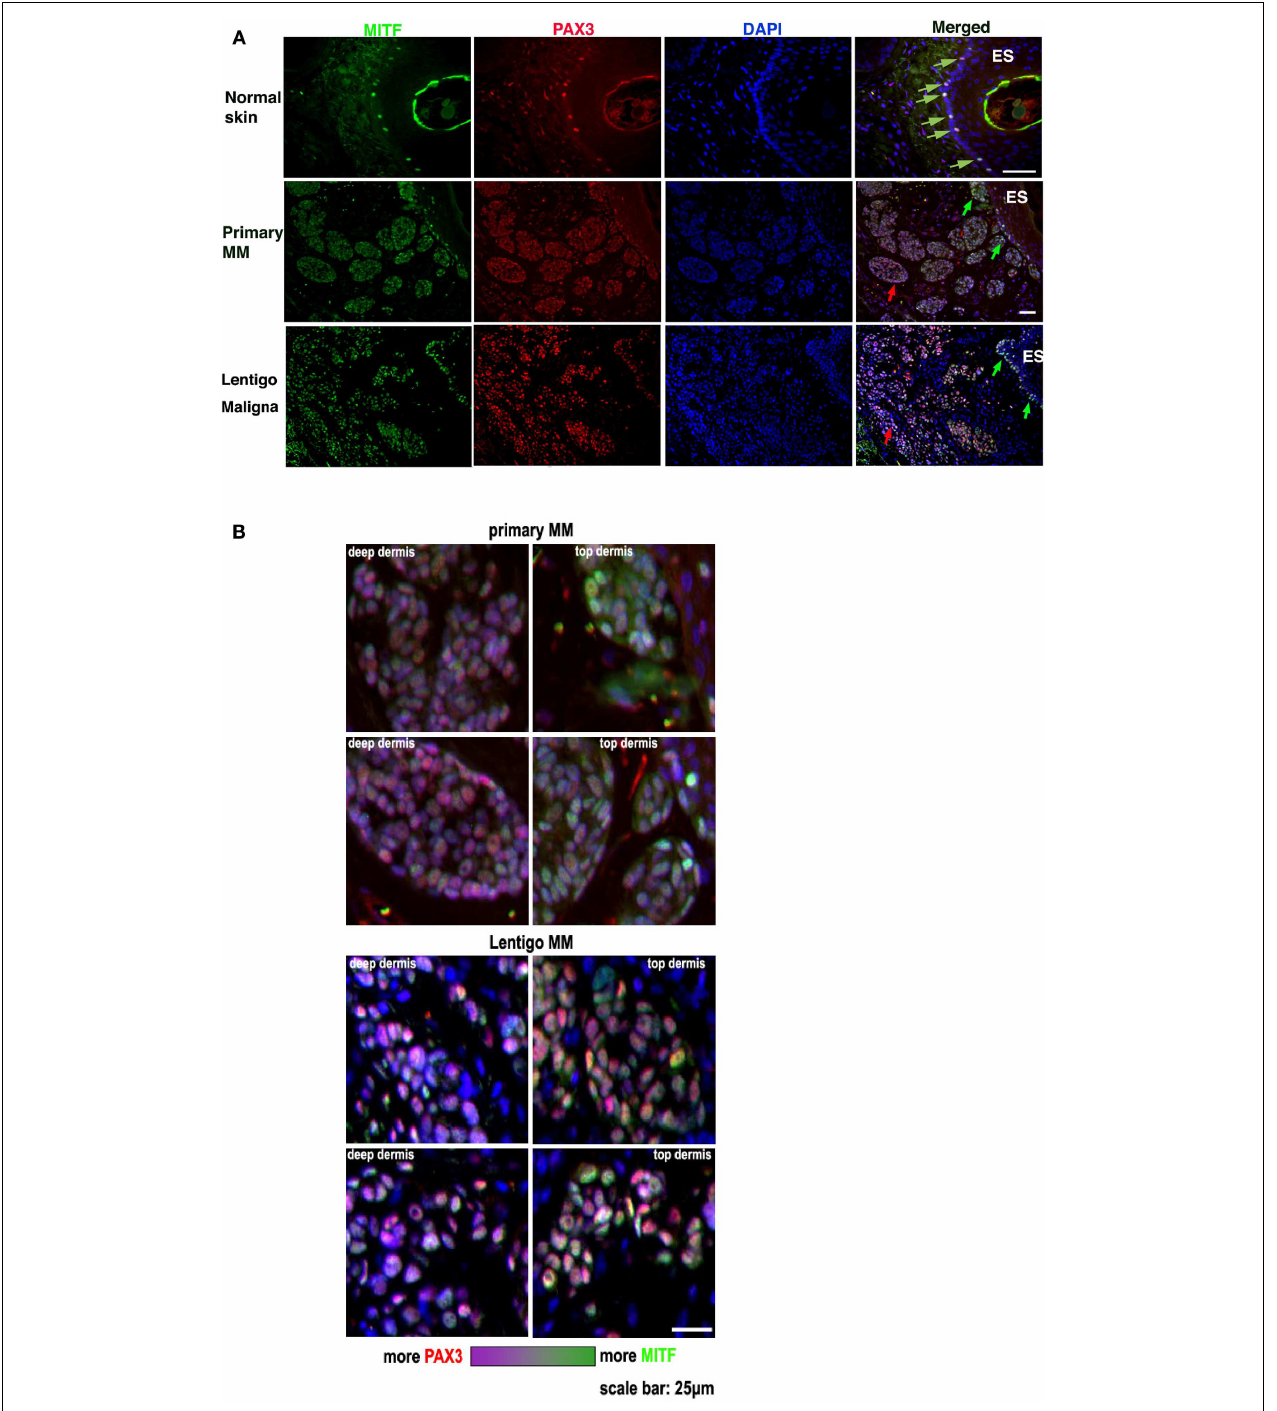
Lentigo maligna melanomas show in greater detail the difference in the relative immunofluorescence color intensity of MITF labeling versus PAX3 labeling in the tumor cells immediately below the skin surface (“Top dermis”) versus cells located deeper in the tumor (“Deep dermis”). Below the panels is shown a color intensity scale, with one end representing relatively strong MITF intensity, and the opposite end representing relatively strong PAX3 intensity.The scale bar in the bottom right image is for all the panels and represents 25 µ